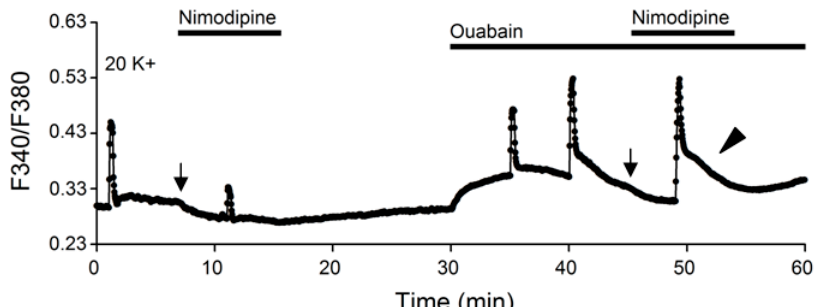
Figure 7. The plateau-like slow decay phase is independent of nimodipine-sensitive Ca 2+ influx. A representative experiment to show the effect of 2 µM nimodipine on the 20 K + -evoked Ca 2+ transient (an average of 12 cells). Note that the plateau-like slow decay phase (marked by arrowhead) still occurred in the presence of nimodipine to block Ca 2+ entry via L-type Ca 2+ channels. Arrows mark the application of 2 µM nimodipine.